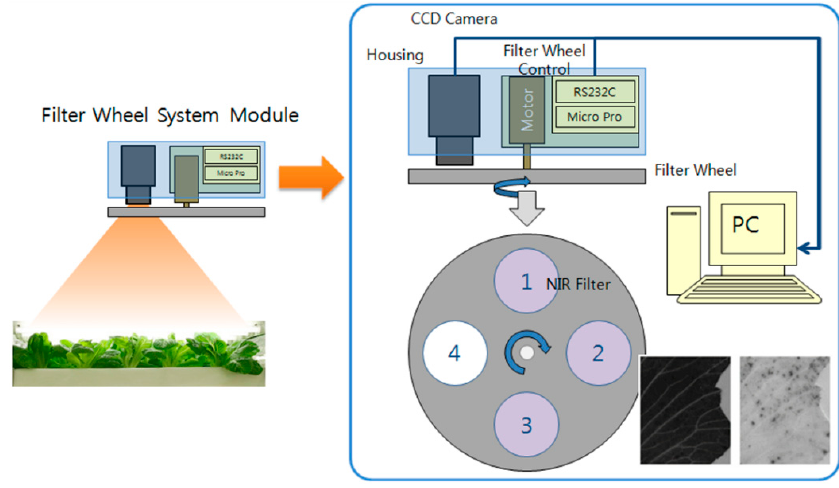
Figure 3. The image acquisition system configuration using the filter wheel for monitoring.